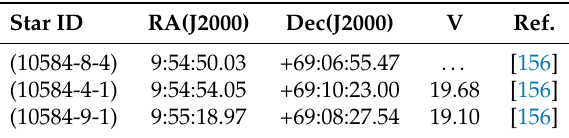
Table 8. Candidate B[e]SGs in